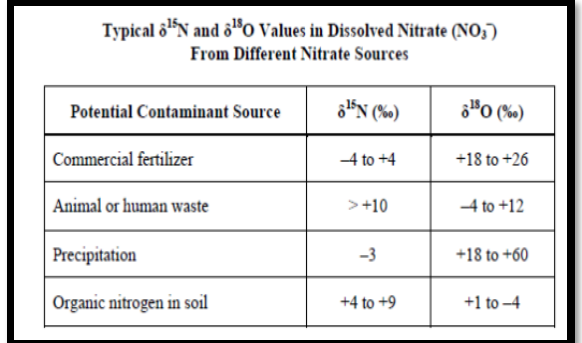
Table 2. Vienna Standard Mean Ocean Water (VSMOW) standards for δ15N and δ18O